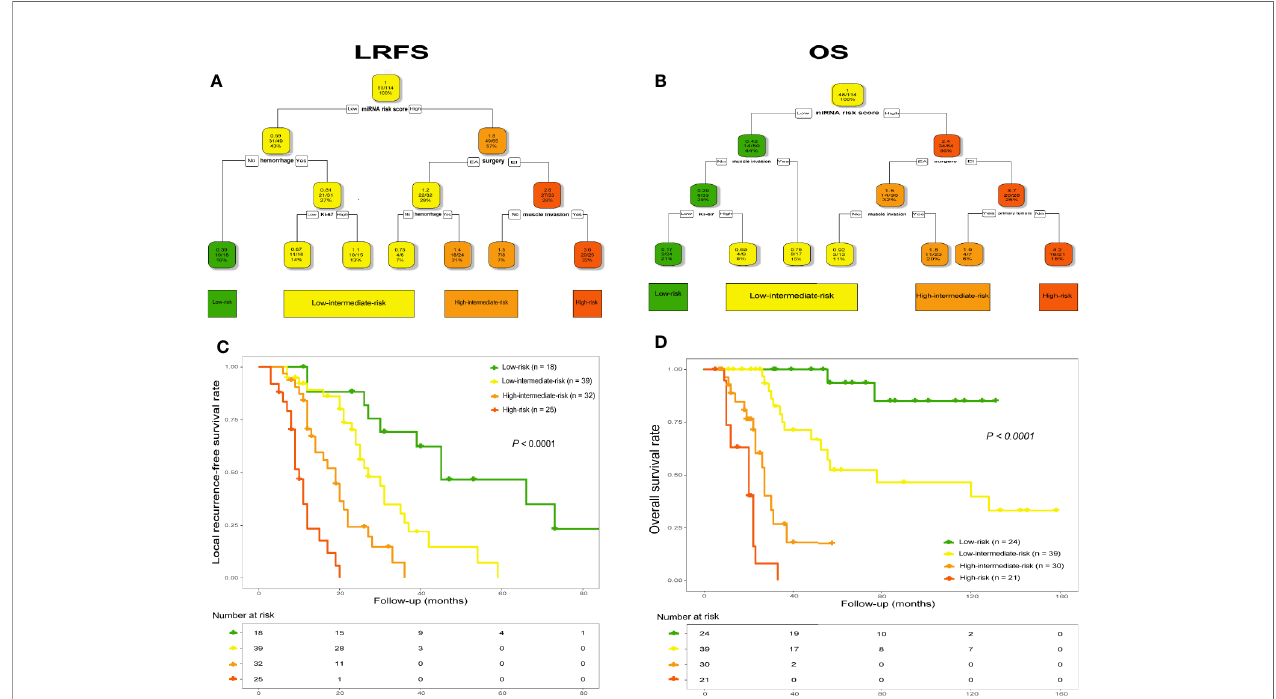
FIGURE 7 | RPA tree for tumor recurrence (A) and survival (B) de fi ned four different risk groups in the pooled data set (n = 114), including “ low-risk ” , “ low- intermediate-risk ” , “ high-intermediate-risk ” and “ high-risk ” . Each node displays the predicted probability of recurrence or death (color code low to high: green-red), the number of events for total patients, and the percentage of observations. Kaplan-Meier curves with log-rank test for LRFS (C) and OS (D) according to the four identi fi ed risk groups. LRFS, local recurrence-free survival; OS, overall survival. RPA, recursive-partitioning